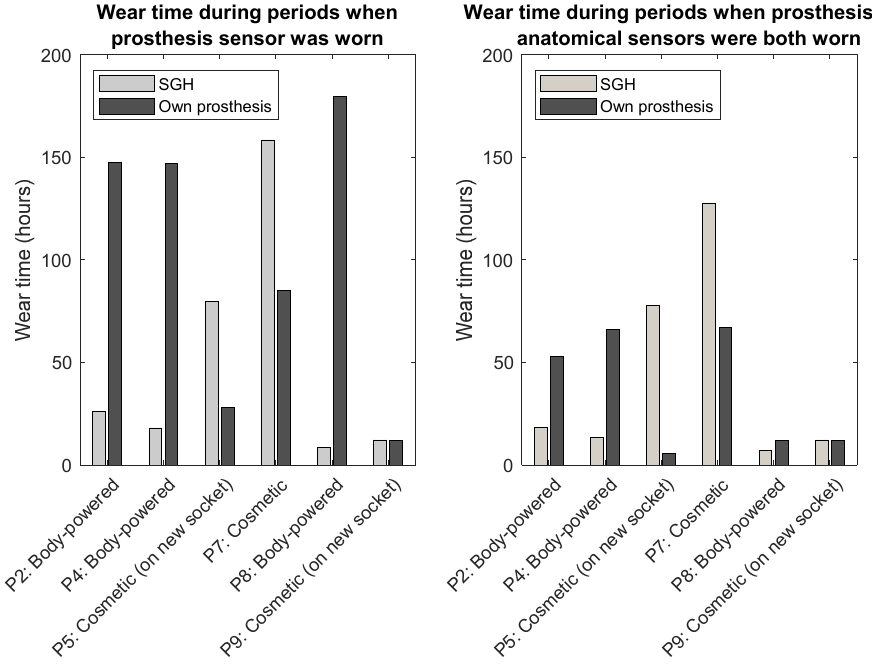
Figure 2. Prosthesis wear time (hours) for participants with full datasets. P: participant; SGH: Self Grasping Hand.